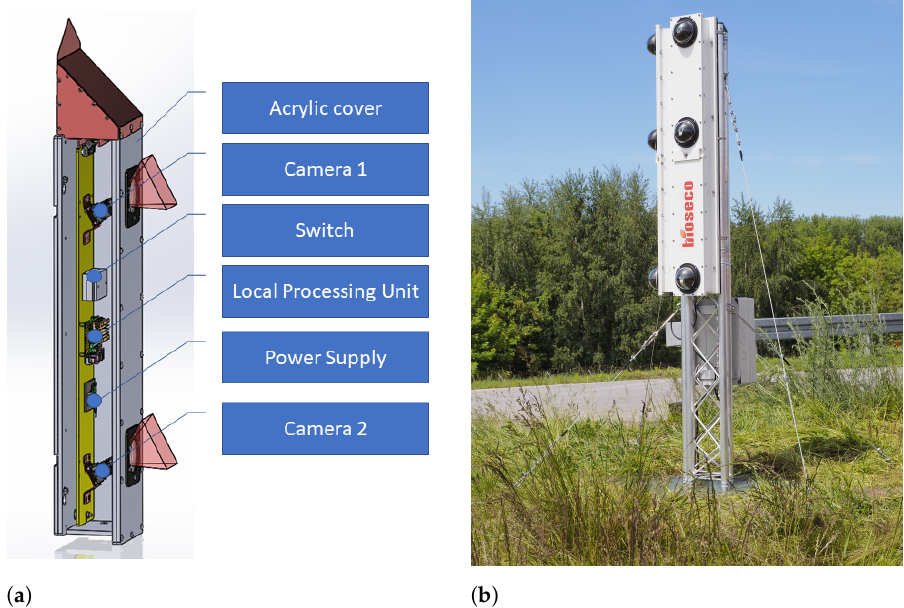
Figure 11. ( a ) The prototype computer drawing of the monitoring module; ( b ) the system installation composed of three monitoring modules and one control unit.